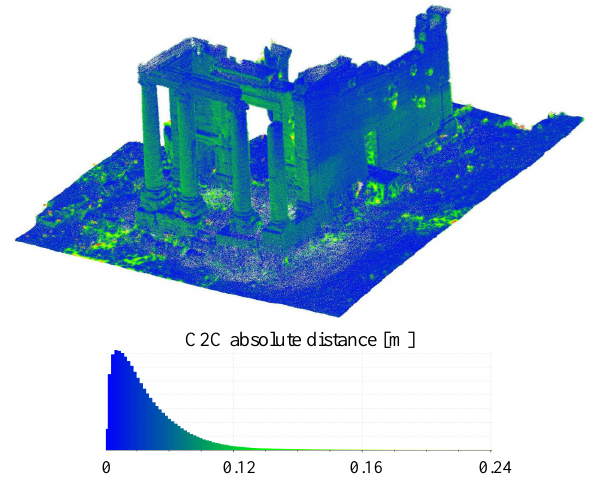
Figure 10. Detail of the point clouds, showing the columns of the temple. The higher noise that characterizes the handheld MMS can be appreciated in